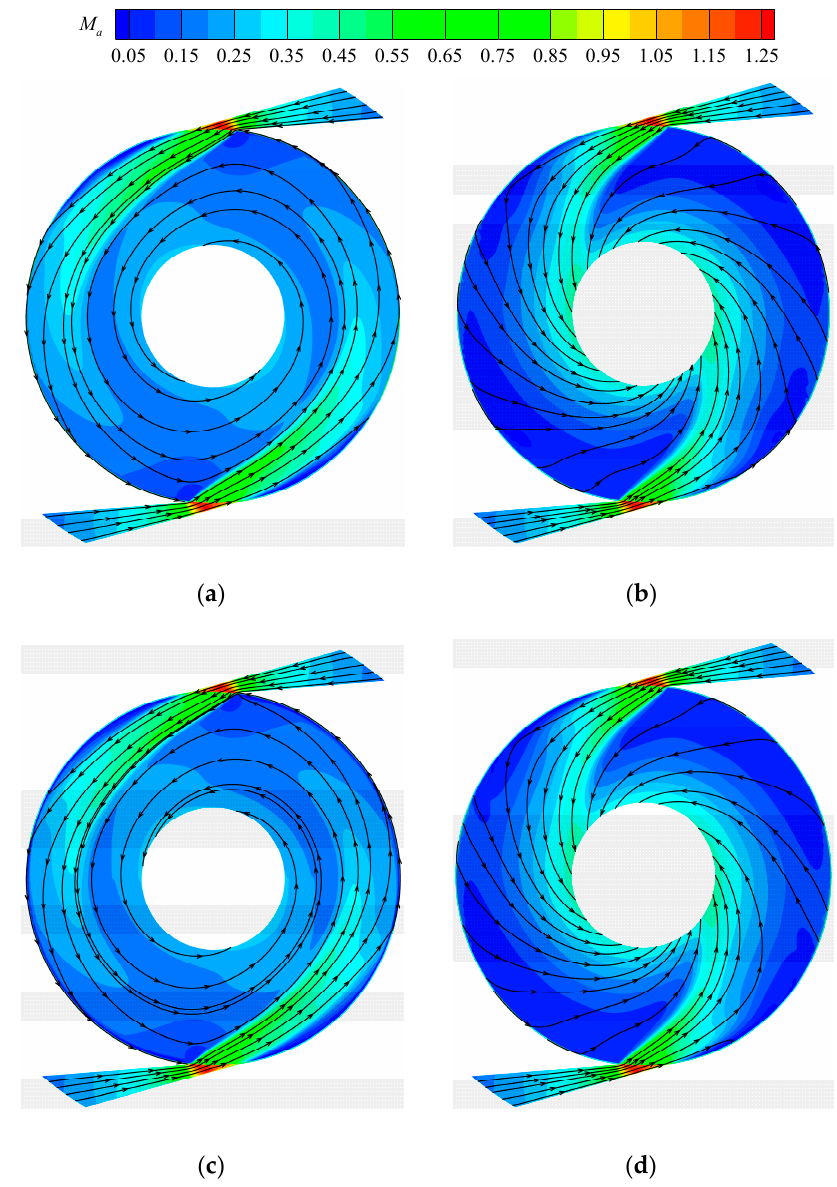
Figure 8. Streamlines and Mach number distributions on the middle of DC1 and DC3 for the one-to-one turbine models with different disc tips. ( a ) DC1 for OTO-B; ( b ) DC3 for OTO-B; ( c ) DC1 for OTO-T-2; ( d ) DC3 for OTO-T-2.